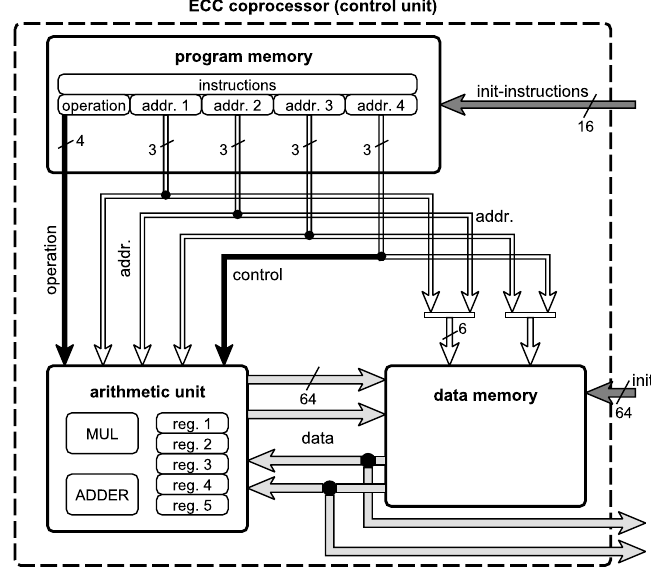
Figure 2. Block diagram of the ECC